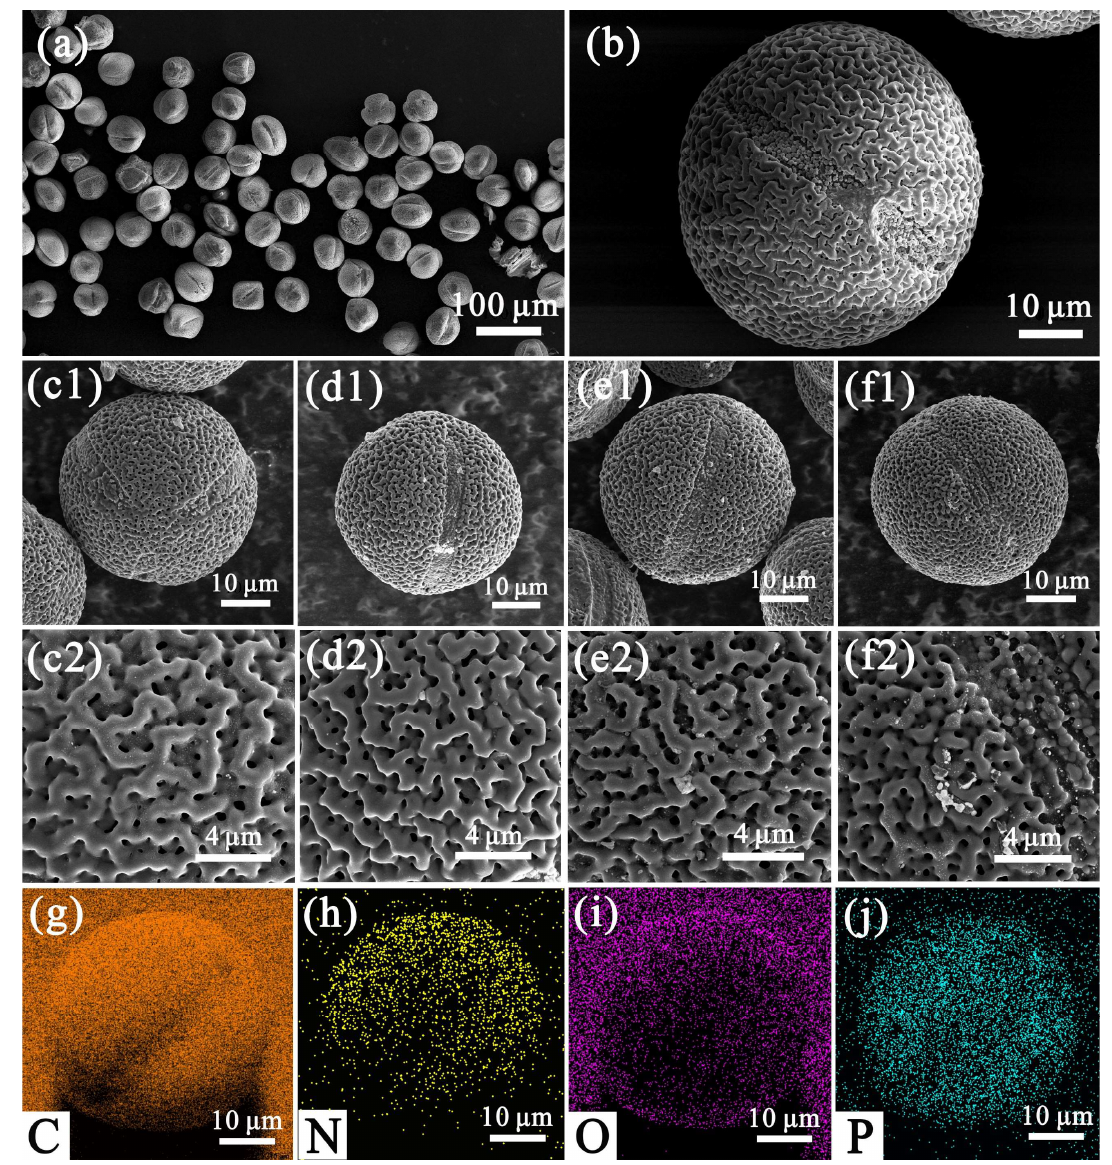
Figure 2. SEM images of ( a , b ) LP-Et, ( c1 , c2 ) LP-C-500, ( d1 , d2 ) LP-C-600, ( e1 , e2 ) LP-C-700, ( f1 , f2 ) LP-C-800; and ( g – j ) element mapping images of C, N, O, and P in LP-C-600.